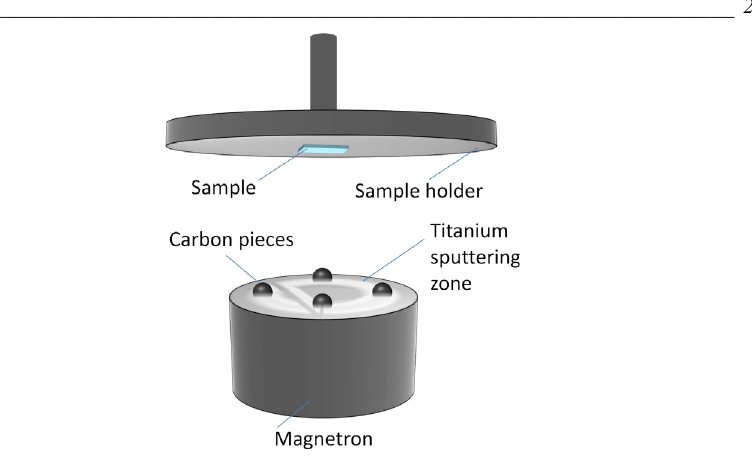
Fig. 1. Experimental set-up scheme during carbon-doped TiO 2